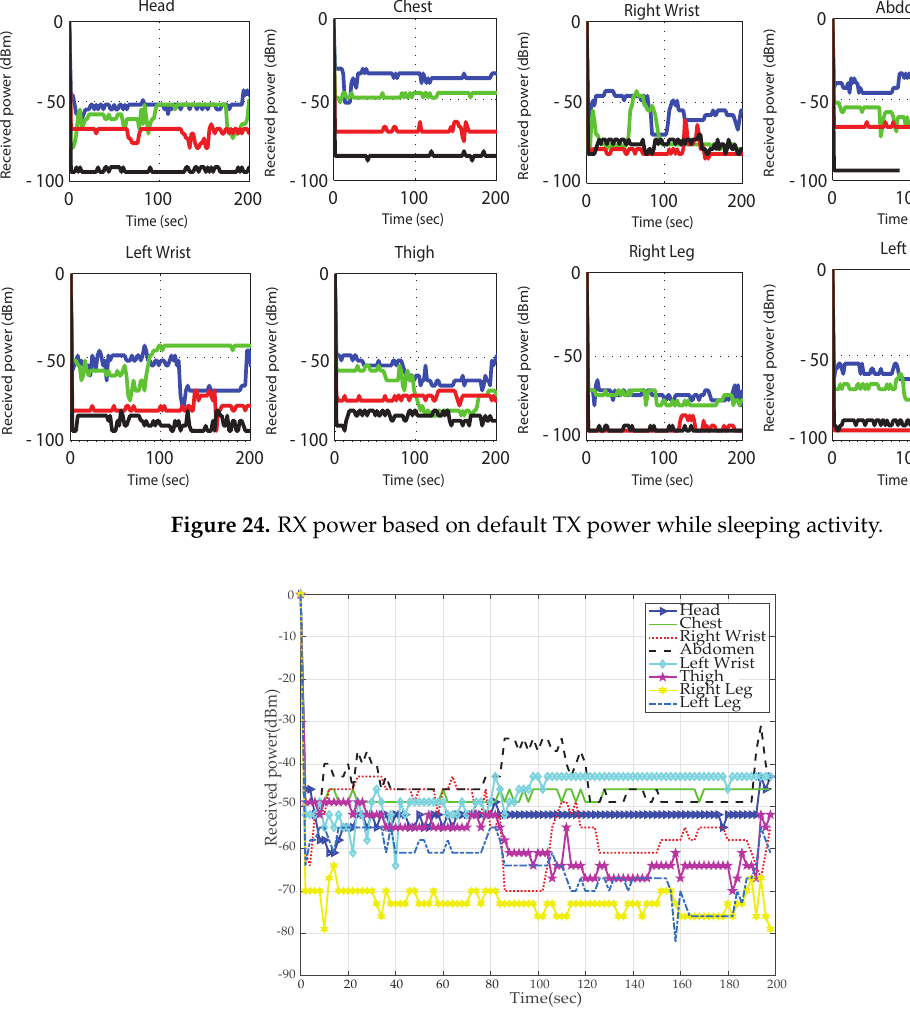
Figure 25. RX power using proposed dynamic control algorithm while sleeping activity.